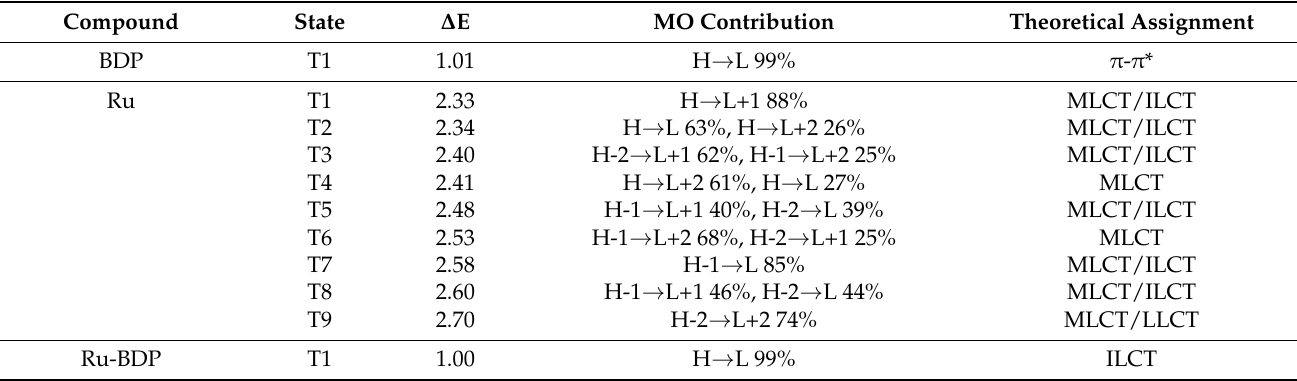
Table 2. Excitation energies ( ∆ E, eV), absorption wavelength ( λ , nm), MO contribution (%) to the triplets excited states for BDP, Ru-m, Ru-BDP.